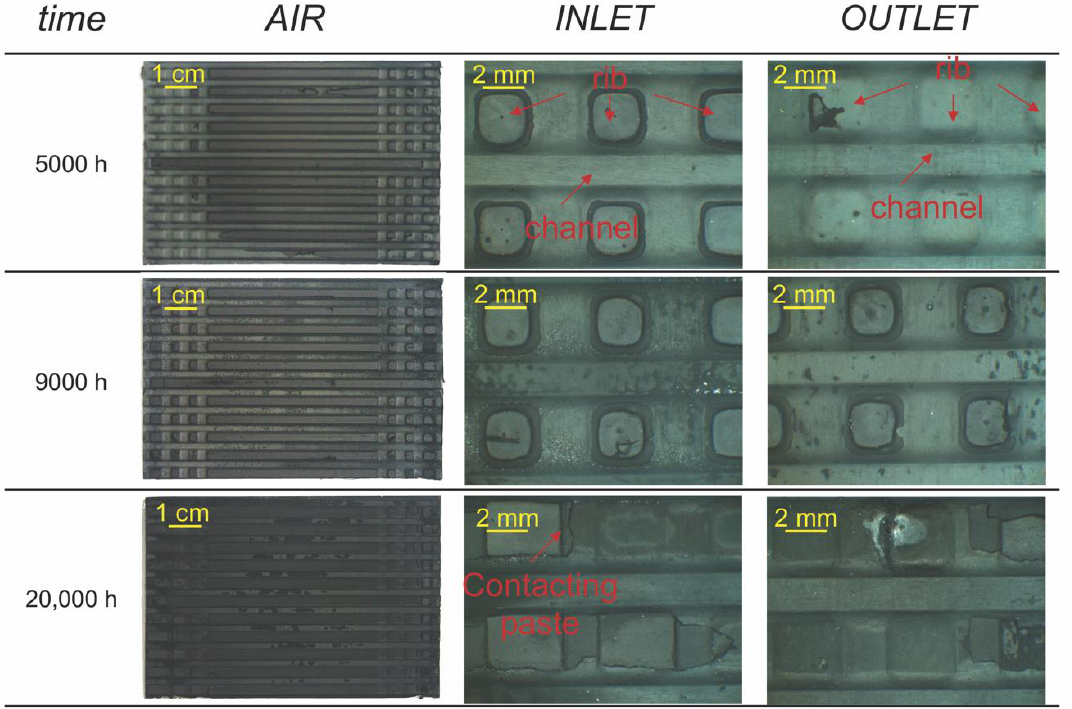
Figure 2. Macroscopic evolution of the MIC operated up to 20,000 h at the air side. IN and OUT most representative sites were also displayed.